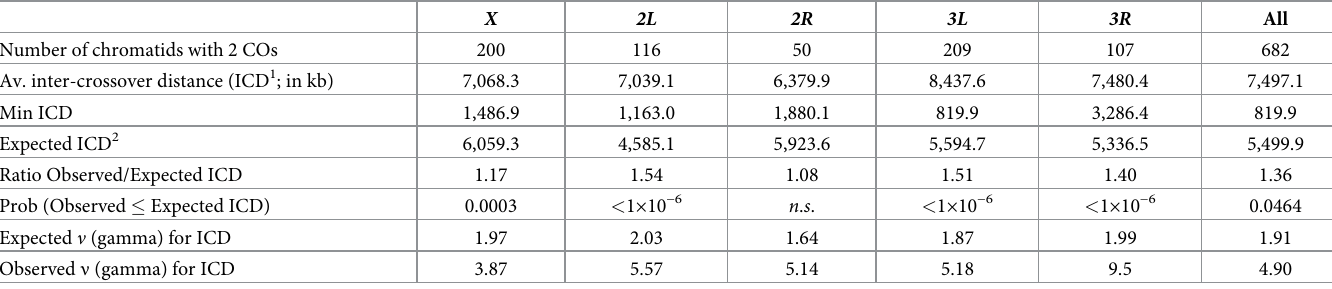
Table 2. Crossover interference in D . yakuba